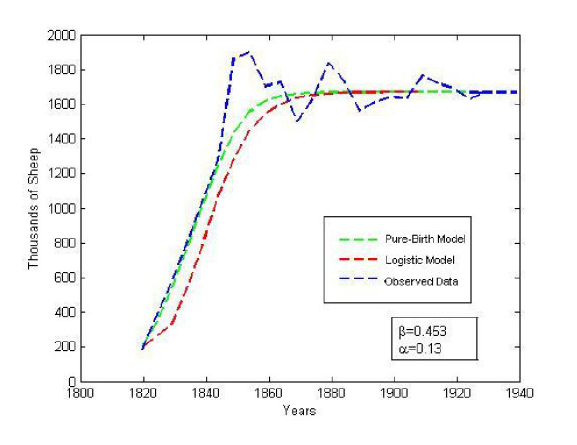
Fig. 2. Growth of Tasmanian sheep